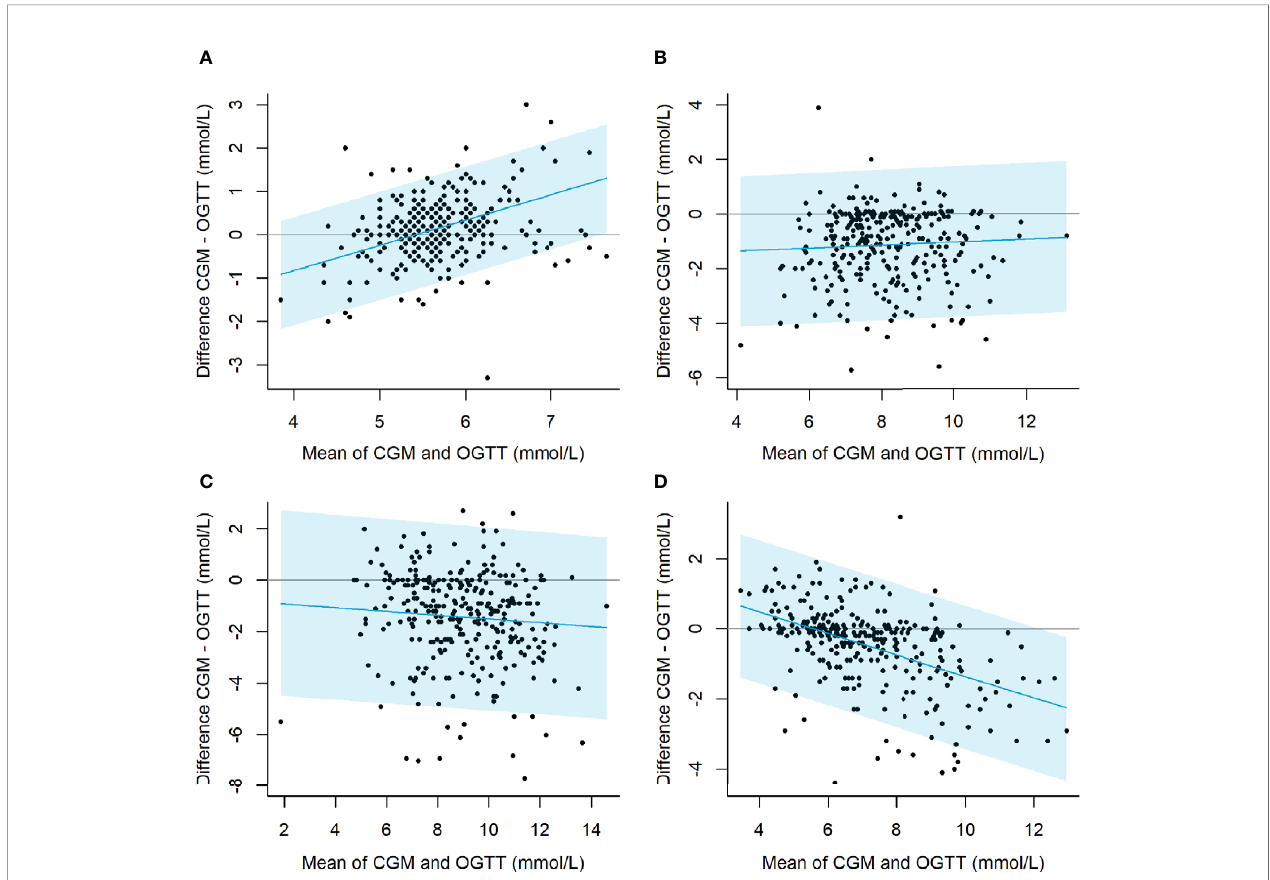
FIGURE 4 | Bland-Altman plots illustrating the agreement between the CGM and OGTT glucose measured during fasting (A) , and after 30 min (B) , 60 min (C) , and 120 min (D) after oral administration of 75 g glucose. Light blue areas indicate limits of agreement. Test of proportional bias: 0 min: P < 0.001, 0 min: P = 0.306, 0 min: P = 0.196, 120 min: P <